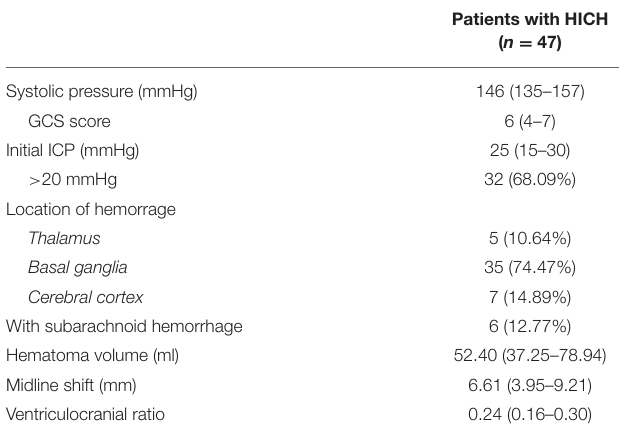
TABLE 1 | Initial ICP and morphological features of patients. TABLE 2 | Selected features and their variation rate.